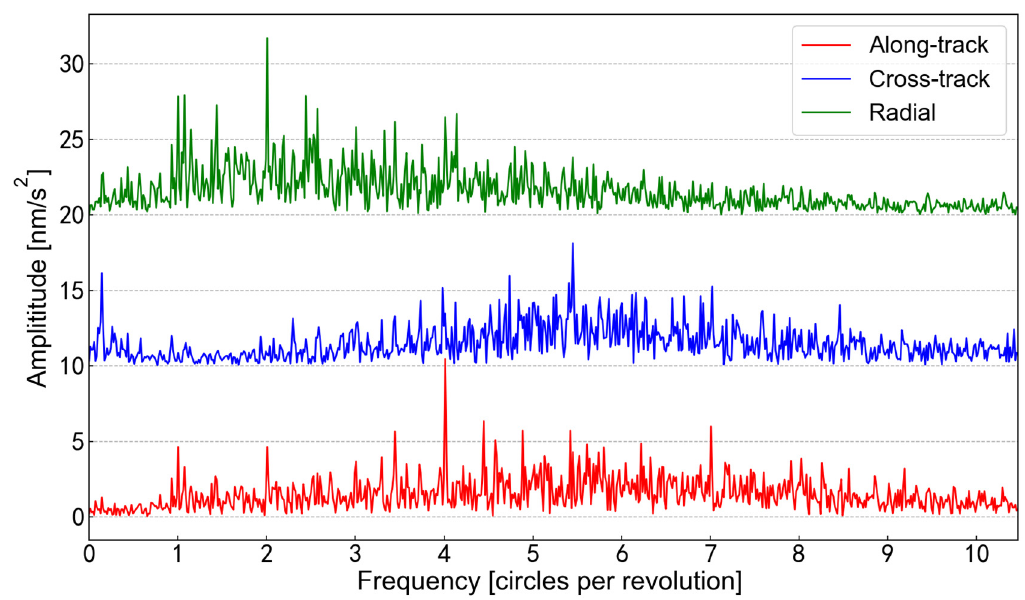
Figure 2. Amplitude spectrum of unmodeled accelerations in the along-track (red), cross-track (blue), and radial (green) directions. Values for the cross-track and radial directions are shifted by +20 nm/s 2 and +10 nm/s 2 , respectively.